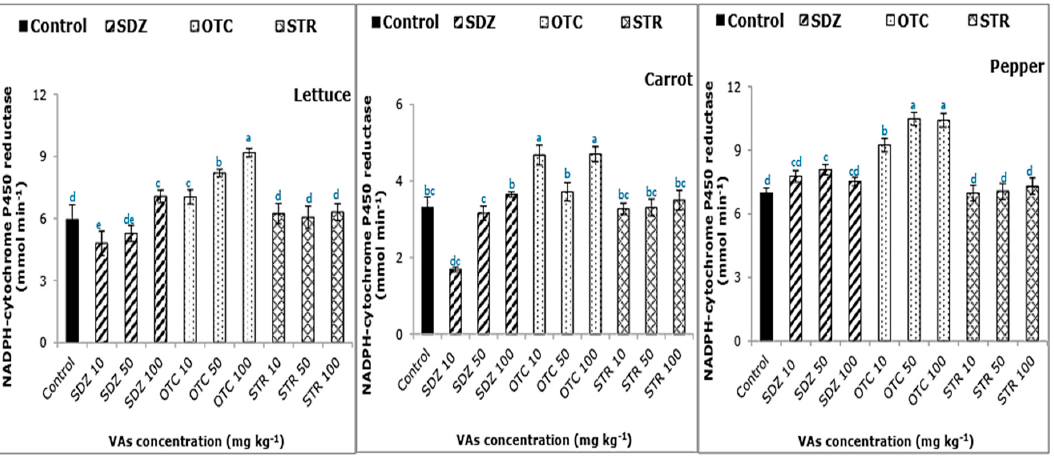
Figure 2. NADPH-cytochrome P450 reductase activity of lettuce, carrot, and pepper grown in soil treated with VAs. Error bars represent standard error. Concentration values followed by different letters are significantly different ( p < 0.05) according to Duncan’s multiple range test. SDZ = Sulfadimethoxine; OTC = Oxytetracycline; STR = Streptomycin.